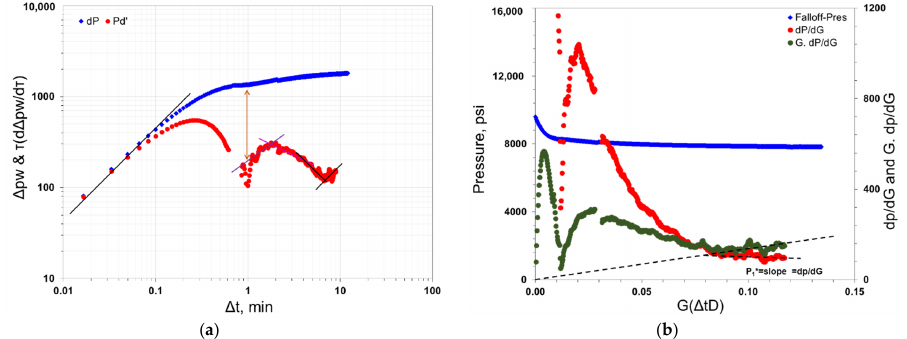
Figure 13. (a) Case #2, Bourdet pressure derivative plots for the main hydraulic fracture treatment for W2. (b) Case #2, G-